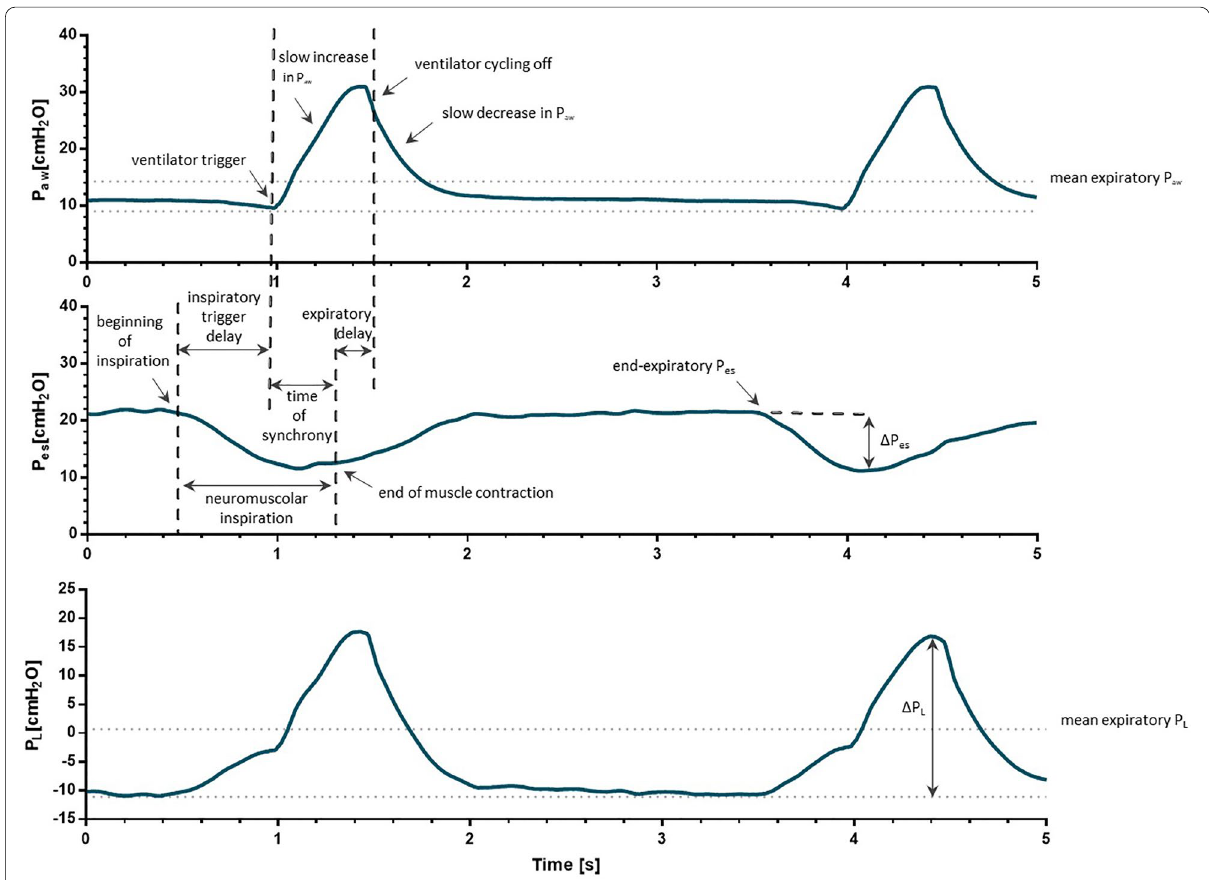
Fig. 3 Representative tracings of respiratory mechanics of a patient treated with helmet pressure support ventilation. Due to the high compliance of the interface, asynchronies are common during helmet NIV. Inspiratory and expiratory trigger delays are displayed, together with the slow increase and decay in airway pressure. Despite the short time of synchrony, the mean expiratory airway pressure is higher than the set PEEP (dotted lines in the Paw tracing) and the mean expiratory transpulmonary pressure is higher than the end-expiratory transpulmonary pressure (dotted lines in the PL tracing). Due to the significant trigger delays caused by interface compliance, inspiratory effort and ventilator assistance are (at least in part) out-of-phase, avoiding excessive dumps in transpulmonary pressure during inspiration. This de-synchronization may further enhance lung protection. Acronyms; PES, esophageal pressure; PL, transpulmonary